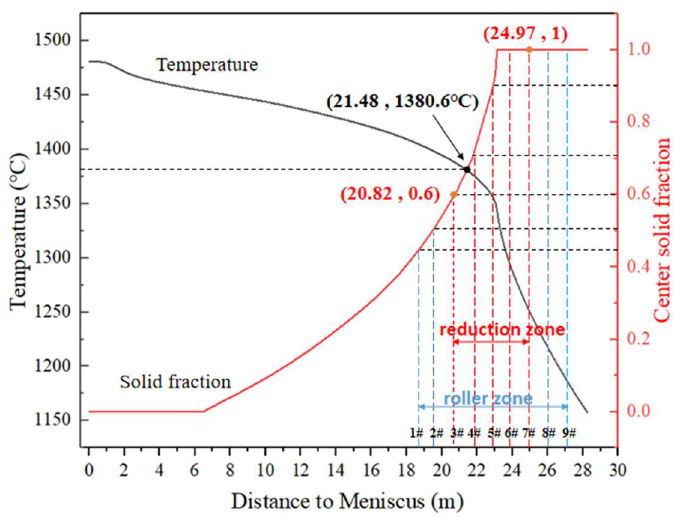
Figure 7. Variations of the temperature and solid fraction of bloom center of the case of casting speed of 0.45 m/min and average superheat of 26 °C.